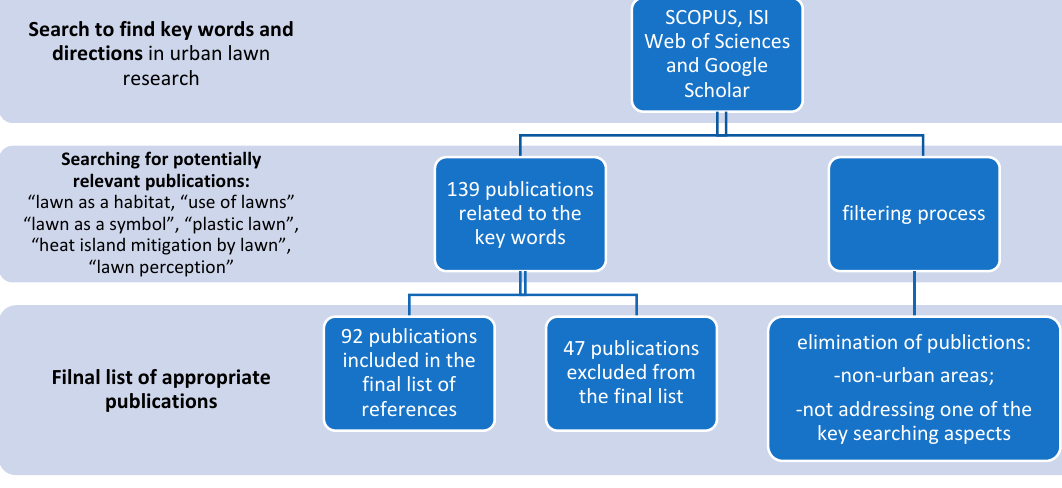
Figure 2. Literature review process. Table 1. Structural analysis of the literature review used in this paper.